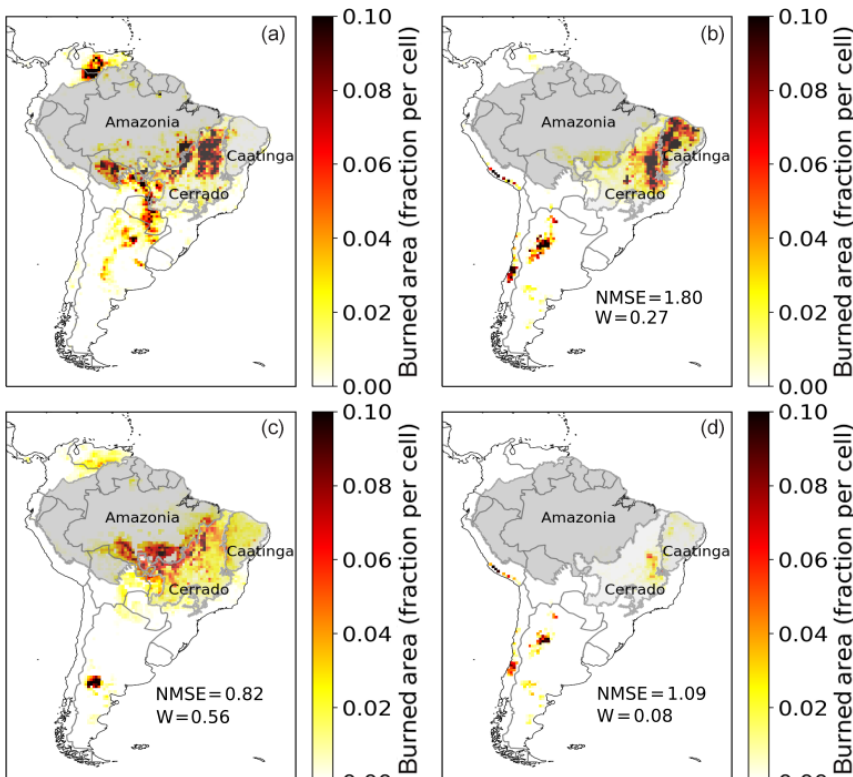
Figure 4. Yearly burned area over a mean from 2005 to 2015 as fraction per cell. (a) GFED4 evaluation data of burned area excluding crops and simulated burned area by SPITFIRE using the (b) NI orig version, (c) VPD optim version, and (d) NI optim